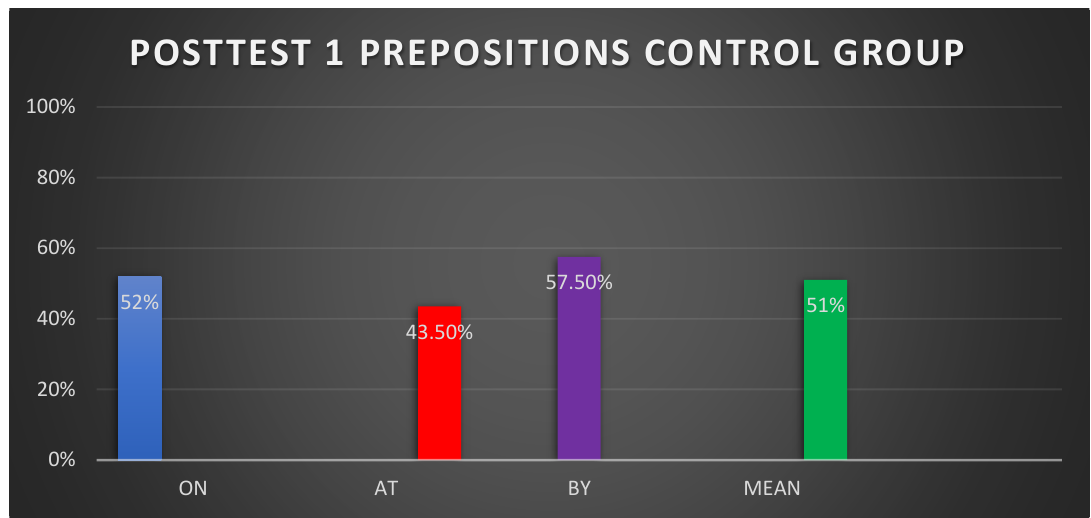
Figure 3. Pretest: percentage of correct answers regarding gender and education